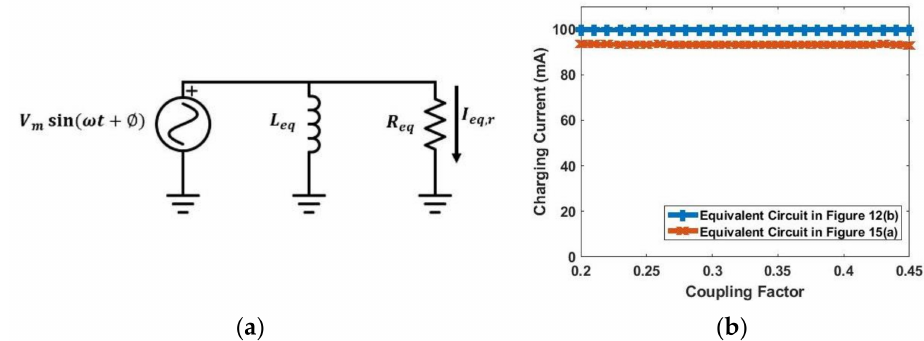
Figure 14. Simulated charging current vs. coupling factor.